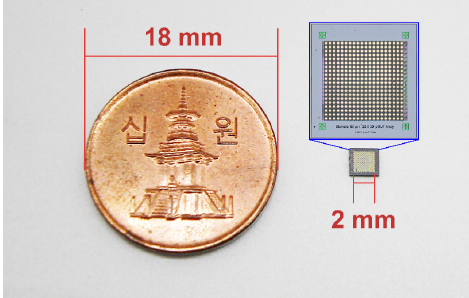
Figure 3. Photograph of the fabricated 20 × 20 AlN pMUT array (400 elements) beside a 10-won Korean coin.